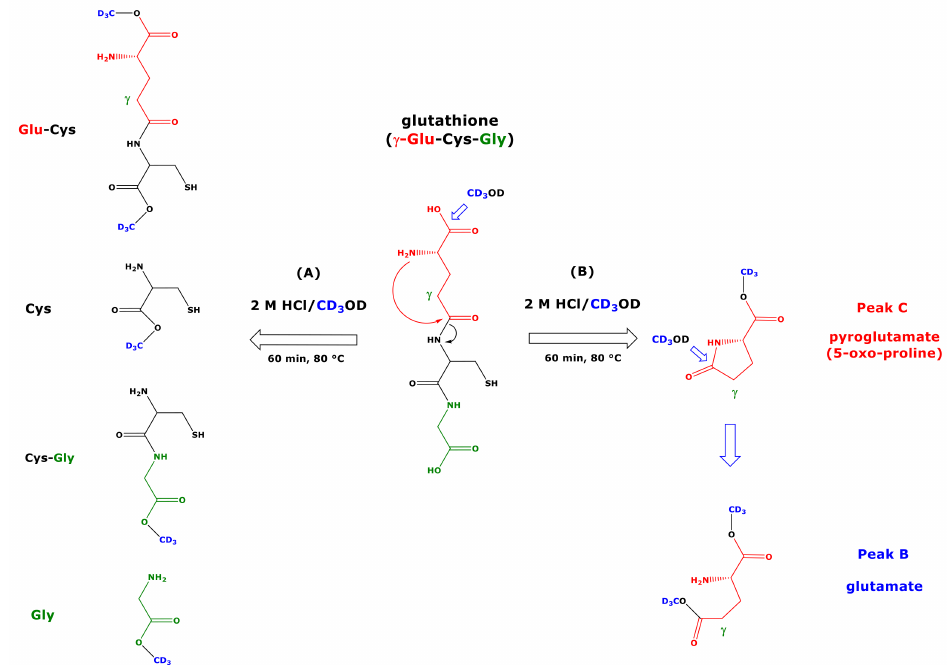
Scheme 1. Proposed reaction products and mechanisms leading to the formation of the indicated ( A ) amino acids and dipeptides, and for ( B ) pyroglutamate upon the reaction of glutathione with 2 M HCl in deuterated methanol for 60 min at 80 ◦ C. Peak B and peak C refer to Figure